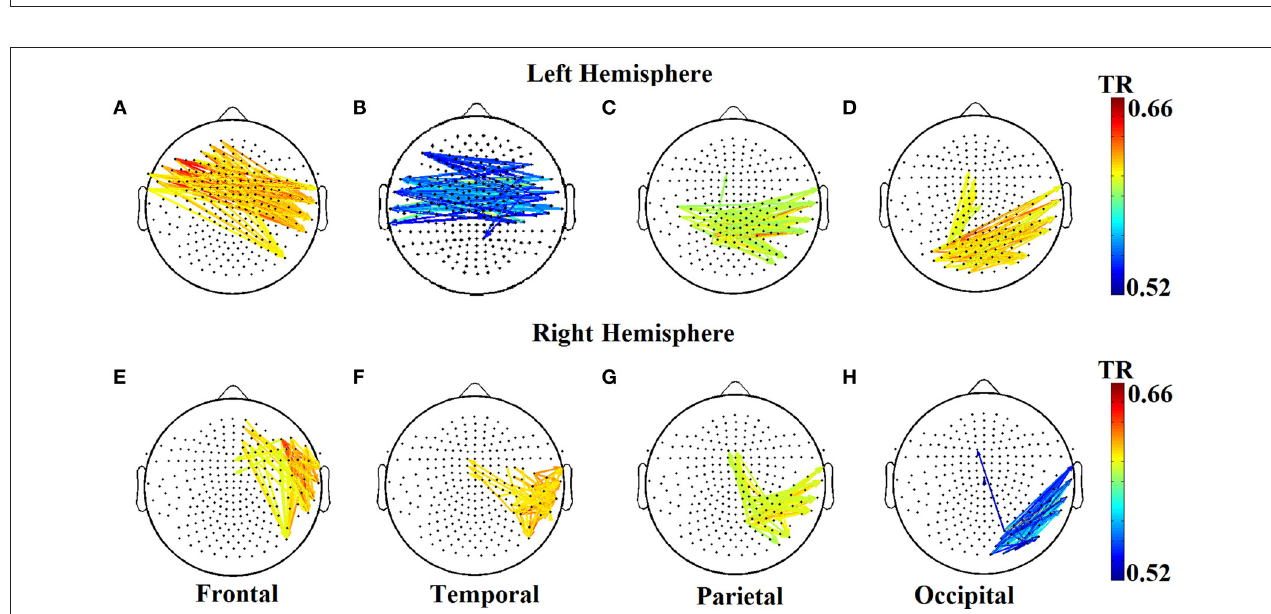
FIGURE 4 | Group-averaged empirical Probability Distribution values of cross-frequency phase-amplitude coupling pairs, revealing a broader repertoire of CFC pairs for RD (B) compared to NI (A) participants who showed a more restricted range of prominent CFC pairs. Lower PD values indicate more significant iPLV values aggregated over time windows and sensor pairs.